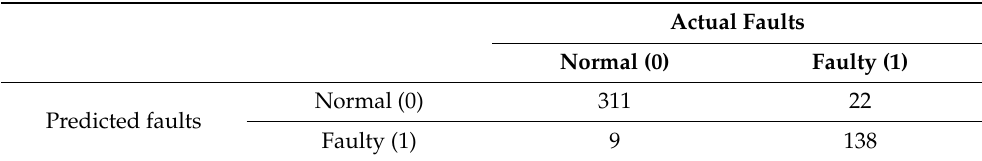
Table 8. Confusion matrix for fault detection of T oa